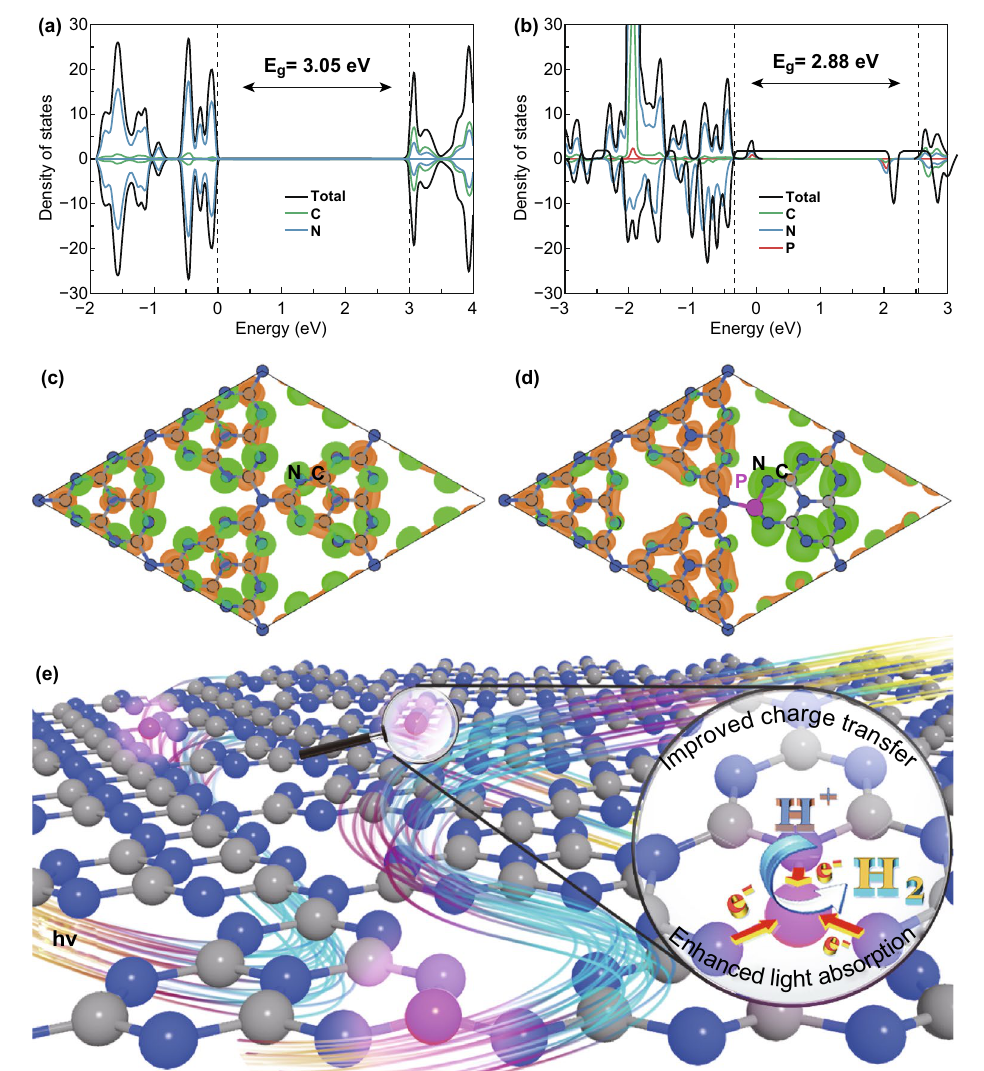
Fig. 8 DFT calculations and photocatalytic mechanism of L‑PCN. Total density of states and partial density of states for a CN and b P‑doped CN. The electron density distributions of the highest occupied (green) and lowest unoccupied orbit (orange) of c CN and d P‑doped CN with an isovalue of 0.02 e Å −3 . e Illustration of the photocatalytic process over L‑PCN photocatalyst for hydrogen evolution. Gray, blue, and pink spheres represent the C, N, and P atoms. (Color figure